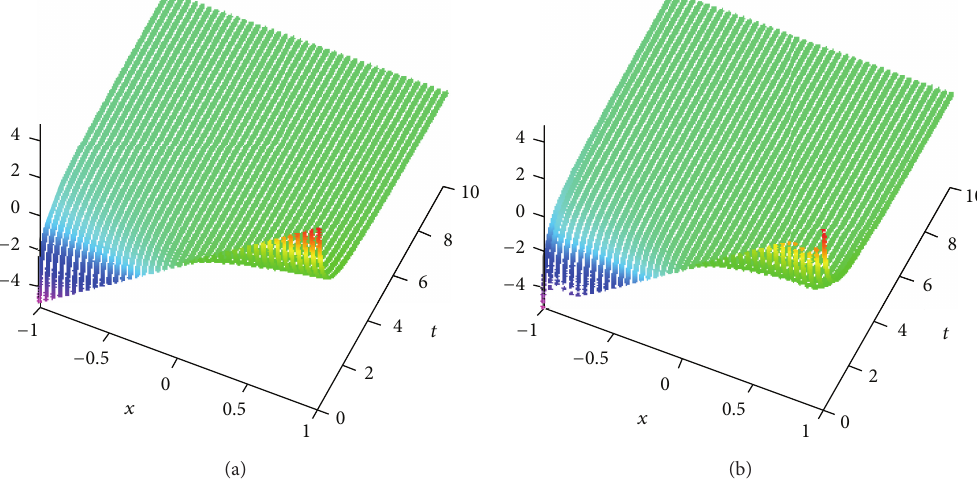
Figure 5: The space-time graph of the estimated solution of Burgers’ equation by using IMQQI (a) and DMQQI (b) for 𝑥 ∈ [−1,1] and 𝑡 ∈ [0, 10] of Experiment 4.